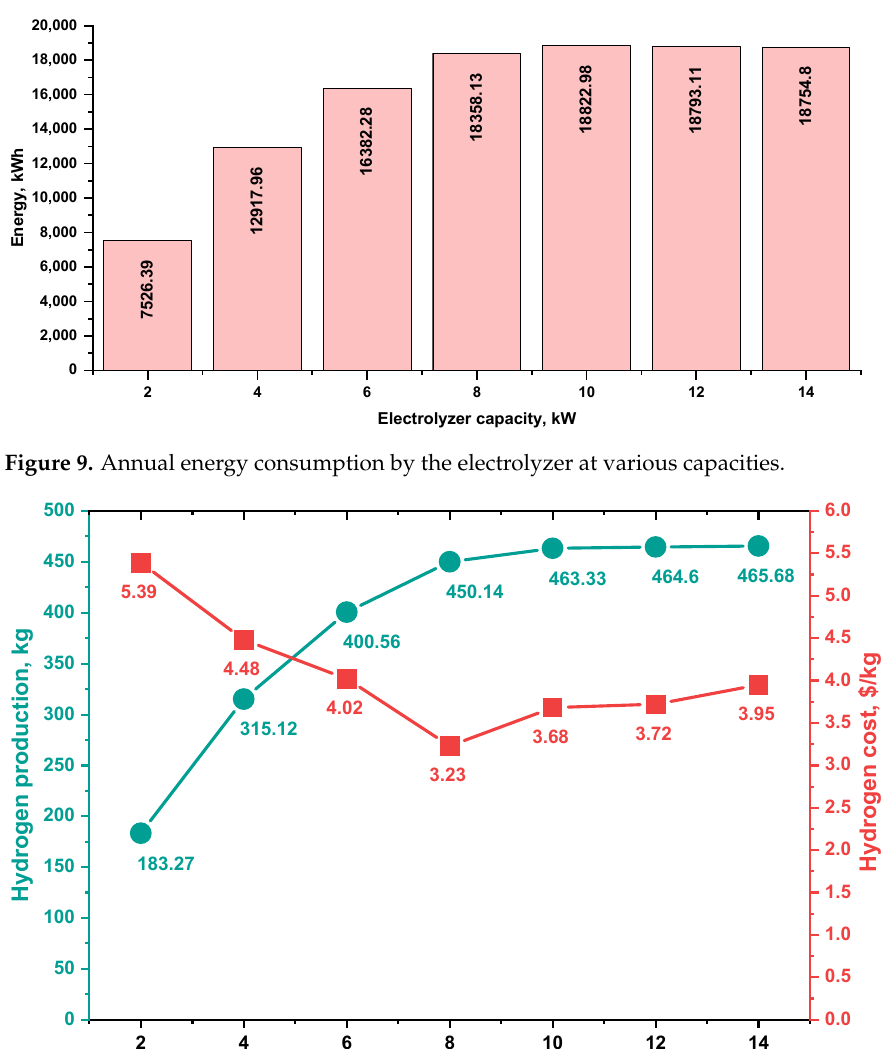
Figure 9. Annual energy consumption by the electrolyzer at various capacities.